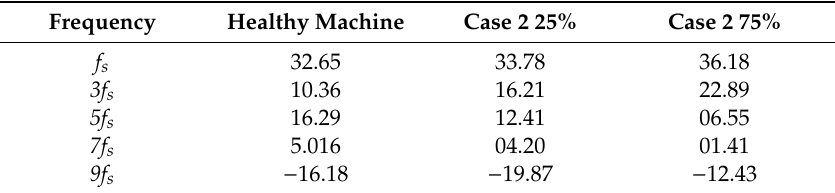
Table 2. Current harmonic components comparison due to case 2 (in dB).